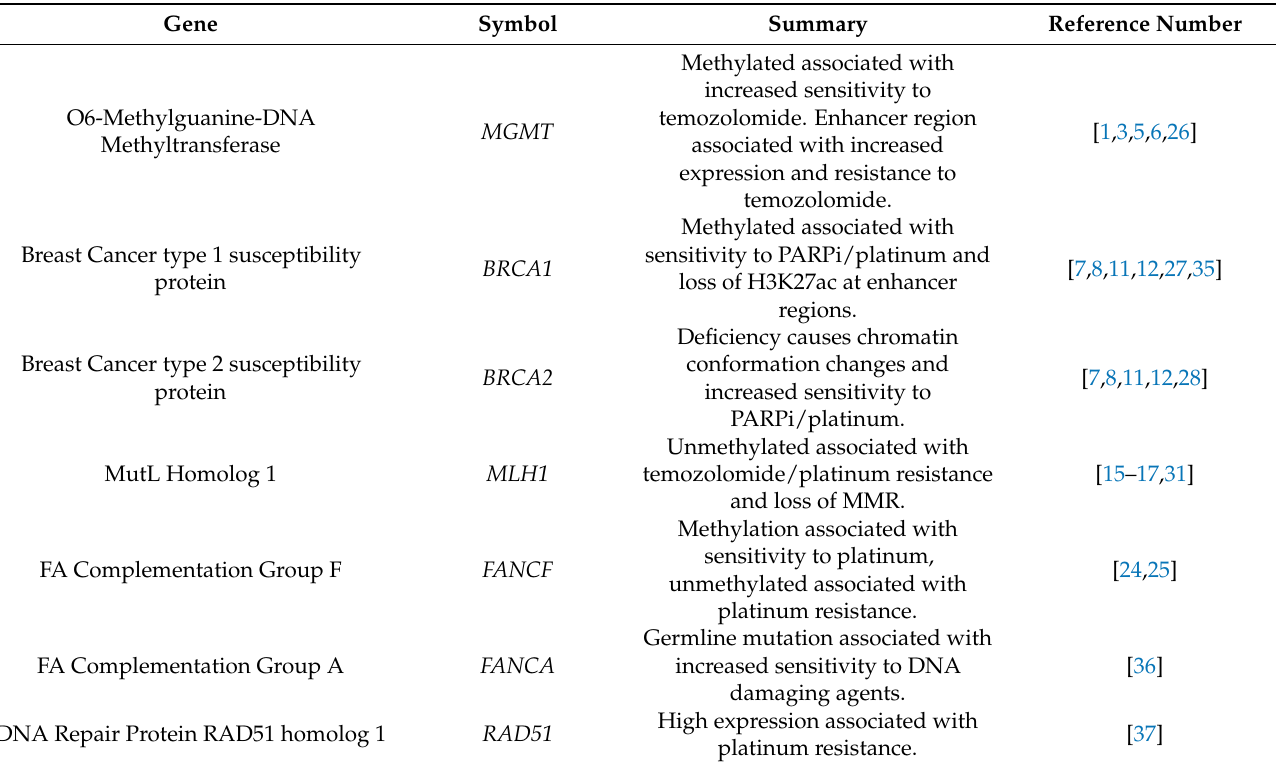
Table 1. Summary of DDR-associated genes, how they can be epigenetically regulated and their involvement in drug